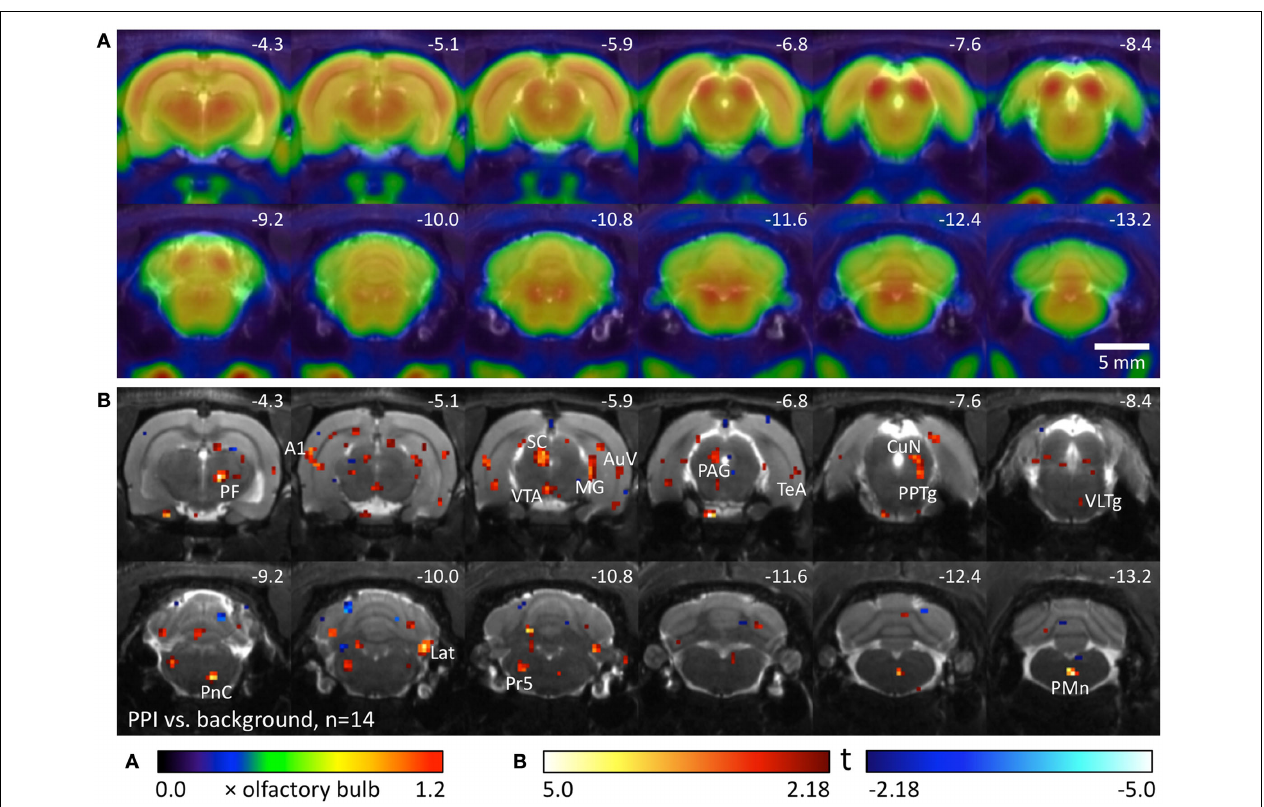
FIGURE 2 | Comparison of PPI session and background noise in well-hearing Black hooded rats. (A) Average FDG images derived from 9 awake Black hooded rats exposed to background noise, projected on an MR image. PET image intensity was normalized to olfactory bulb. (B) T-map computed from a paired t -test comparing images from the PPI-PET session with those from background noise control. Red color indicates voxels with higher FDG uptake in the PPI-PET session. Blue color indicates voxels with higher FDG uptake during background noise. Only voxels with p -values < 0.05 (uncorrected) are shown. Numbers